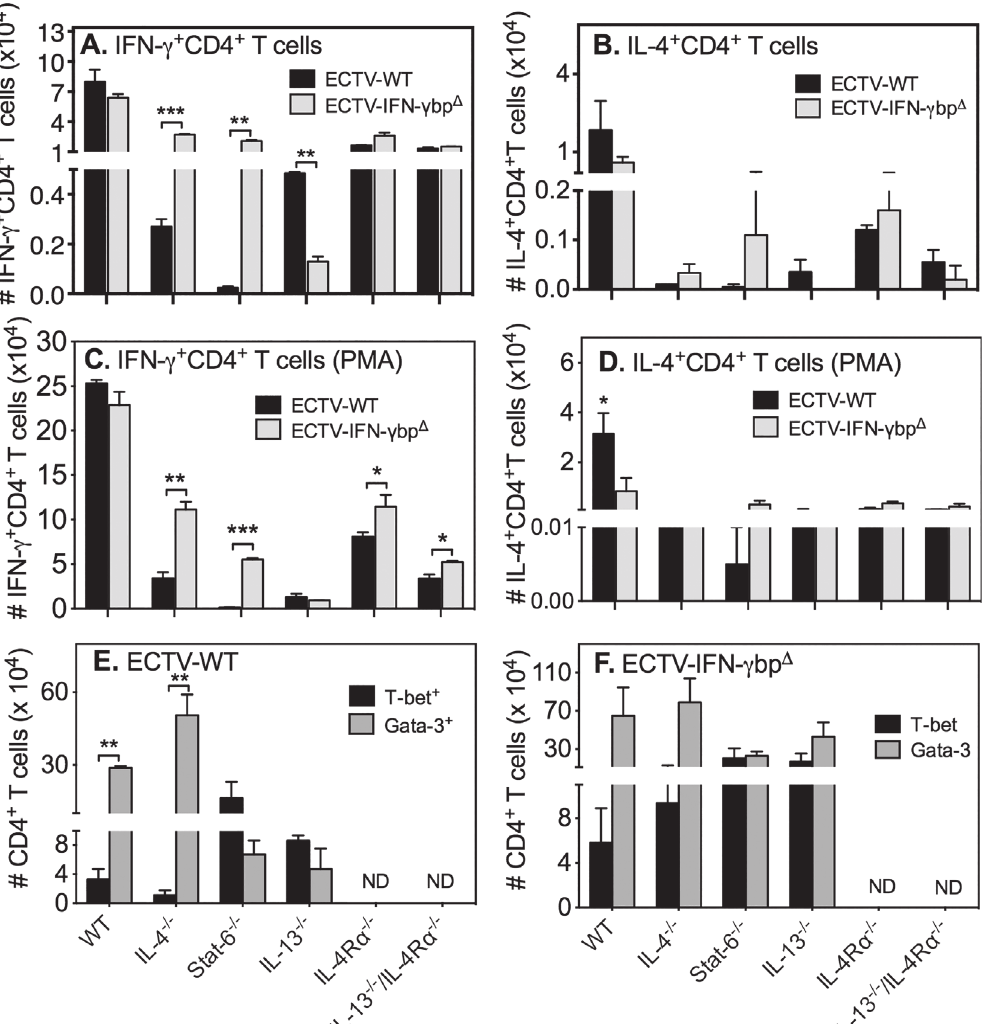
Fig 5. Numbers of CD4 T cells expressing IFN- γ , IL-4, T-bet or GATA-3. Mice (n = 5 – 10/group) were infected with ECTV-WT or ECTV-IFN- γ bp Δ , sacrificed on day 7 p.i. and splenocytes used for intracellular staining for IFN- γ , IL-4, T-bet or GATA-3 without stimulation (A and B) or with PMA + ionomycin stimulation (C and D). Shown are means of absolute numbers of IFN- γ + CD4 T cells with no stimulation (A) or PMA + ionomycin stimulation (C), IL-4 + CD4 T cells with no stimulation (B) or PMA + ionomycin stimulation (D). Also shown are means of absolute numbers of T-bet + and GATA-3 + CD4 T cells following ECTV-WT (E) or ECTV-IFN- γ bp Δ (F) infection. Two-way ANOVA followed by Fisher ’ s LSD test for significance was used. For panel A, numbers of IFN- γ + CD4 T cells in WT mice for both viruses were significantly higher (p < 0.0001) compared to numbers in all GKO strains. In IL-4 − / − and STAT-6 − / − mice, IFN- γ + CD4 T cell numbers generated by ECTV-IFN- γ bp Δ infection were significantly higher ( p = 0.0005 and p = 0.0013, respectively) compared to WT virus infection. In IL-13 − / − mice, IFN- γ + CD4 T cell numbers generated by WT virus infection were significantly higher ( p = 0.0034) compared to ECTV-IFN- γ bp Δ infection. For panel B, numbers of IL-4 + CD4 T cells in WT mice for both viruses were significantly higher (p < 0.01) compared to numbers in all GKO strains. No other significant differences were found. For panel C, numbers of IFN- γ + CD4 T cells in WT mice for both viruses were significantly higher (p < 0.0001 in ECTV-WT and p < 0.001 in ECTV-IFN- γ bp Δ ) compared to numbers in all GKO strains. In IL-4 − / − , STAT-6 − / − IL-4R α − / − and IL-13 − / − / IL-4R α − / − mice, IFN- γ + CD4 T cell numbers generated by ECTV-IFN- γ bp Δ infection were significantly higher compared to WT virus infection. For panel D, numbers of IL-4 + CD4 T cells in WT mice for ECTV-WT virus was significantly higher (p < 0.05) compared to numbers in all GKO strains. In WT mice, IL-4 + CD4 T cell numbers generated by WT virus infection were significantly higher ( p < 0.05) compared to ECTV-IFN- γ bp Δ infection. For panel E, T-bet + CD4 T cell numbers were significantly increased (p < 0.01) in STAT-6 − / − and IL-13 − / − mice compared to WT animals. For panel F, no significant differences were found between strains. Data shown for panels A and B are from one of two independent experiments with similar results. Data shown for panels C-F are from one experiment. * , p < 0.05; ** , p < 0.01; *** , p <